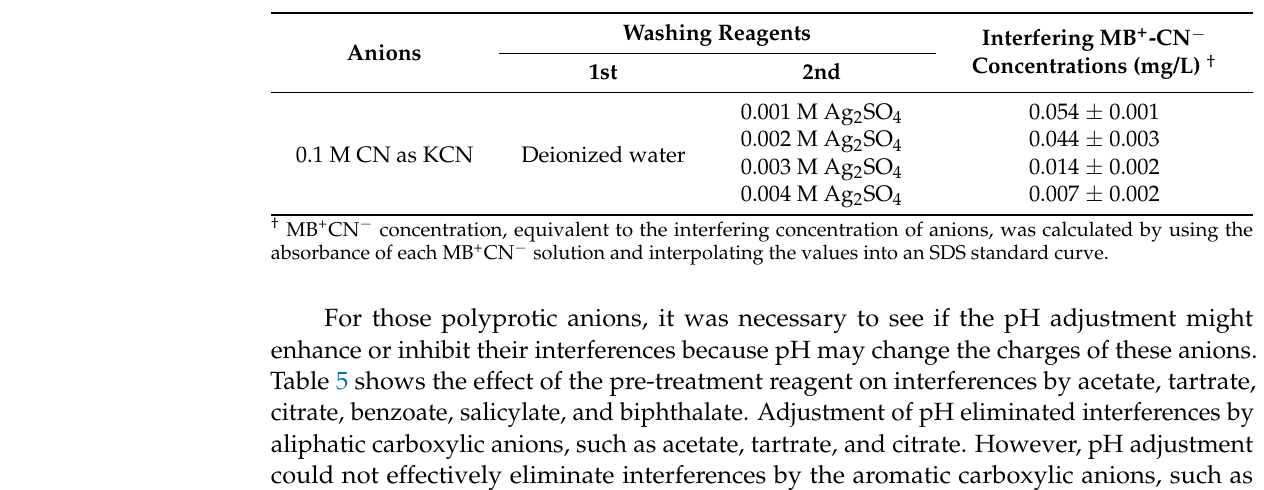
Table 4. Effect of Ag 2 SO 4 washing on cyanide ion (CN − ) interferences in MIBK-DCE extraction.